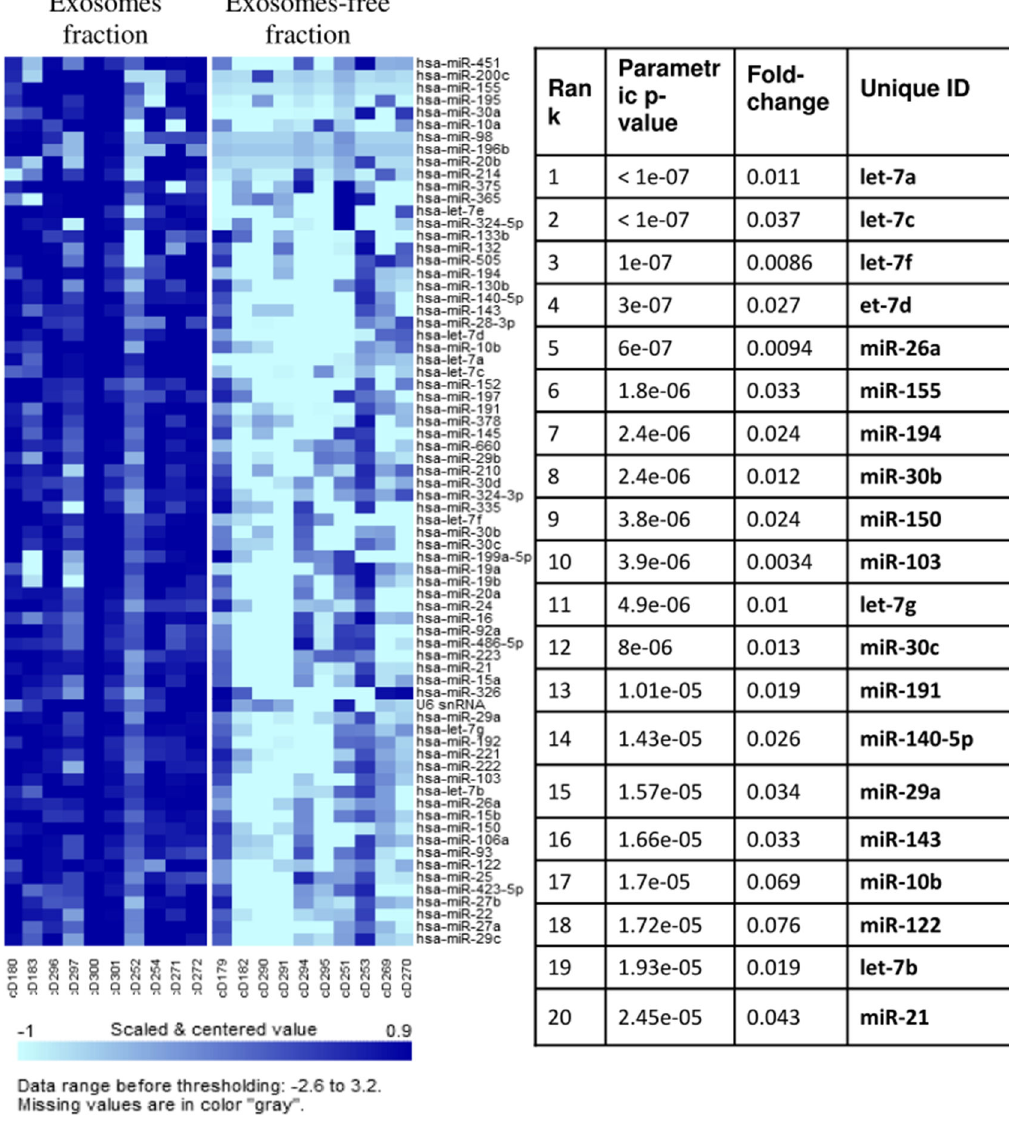
Figure 3. Enrichment in expression of various miRNA species in the ExoQuick-precipitated fraction (“Exosomal fraction”) compared with the ExoQuick-depleted fraction (“Exosome-free fraction”) of the same pre-operative plasma samples from patients with lung